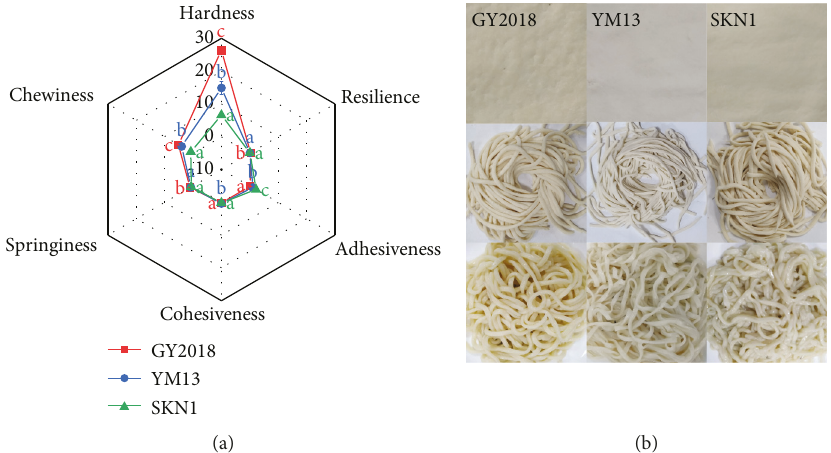
Figure 1: Textural properties of cooked noodles of GY2018, YM13, and SKN1 (a); dough sheet, raw noodles, and cooked noodles views prepared from GY2018, YM13, and SKN1